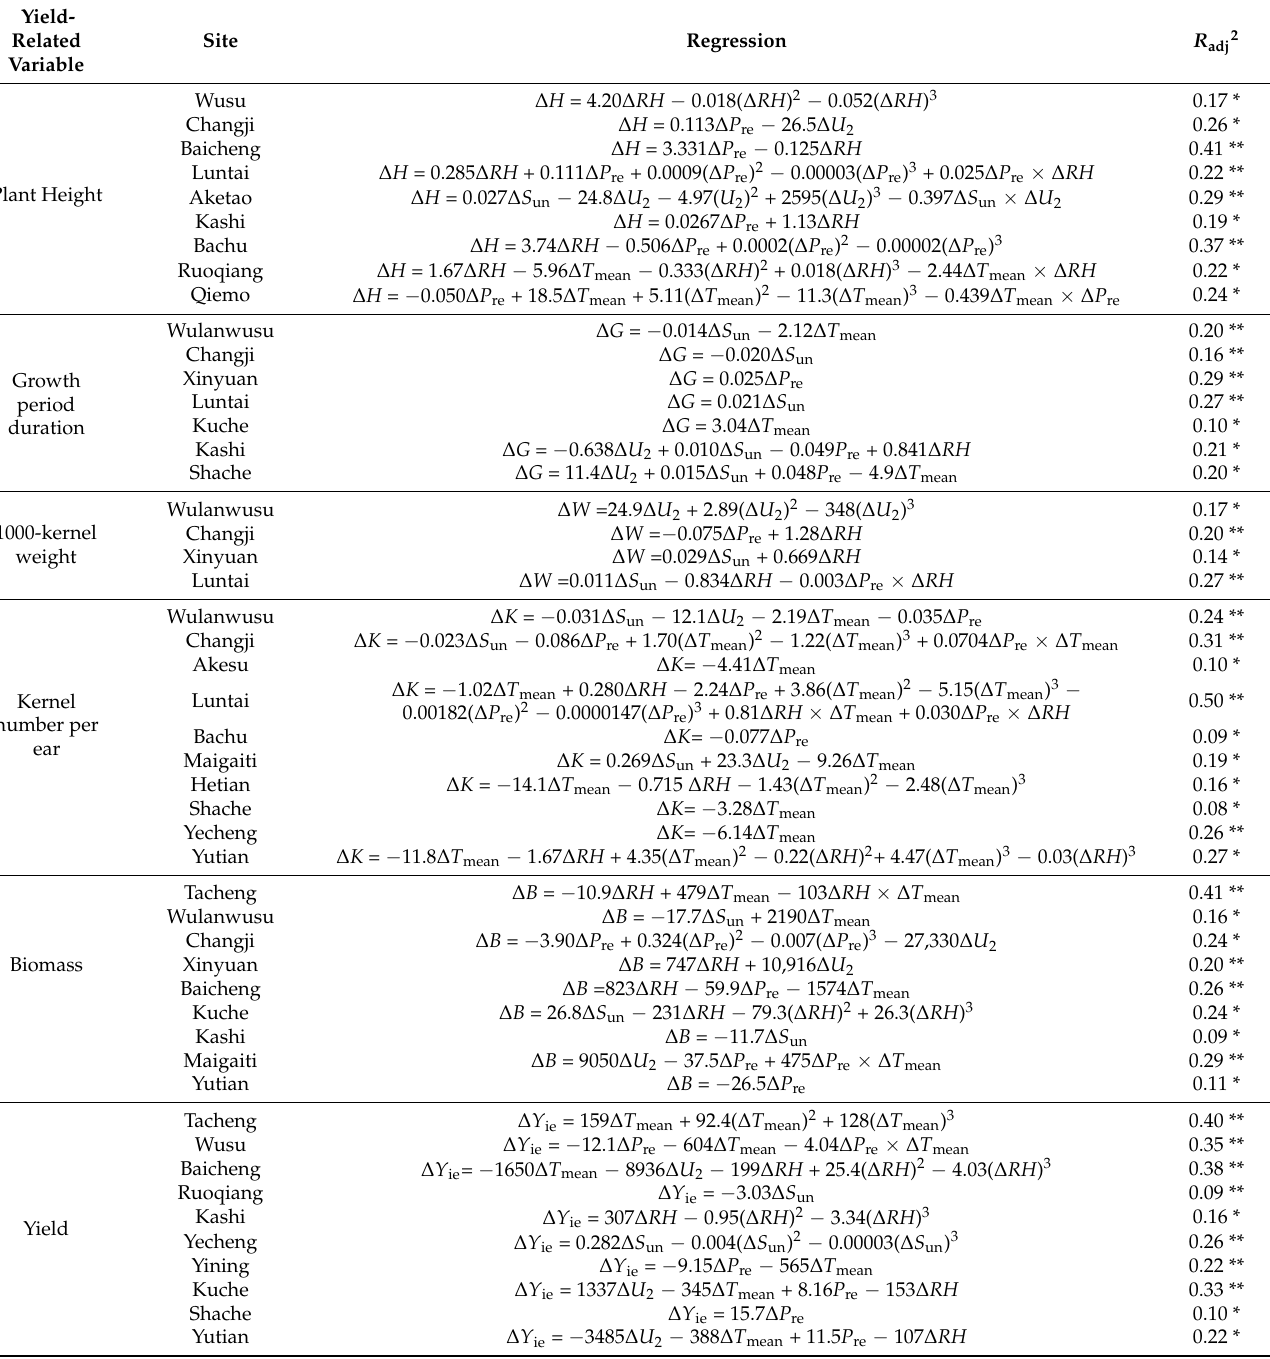
Table 7. The selected best functions for wheat yield-related